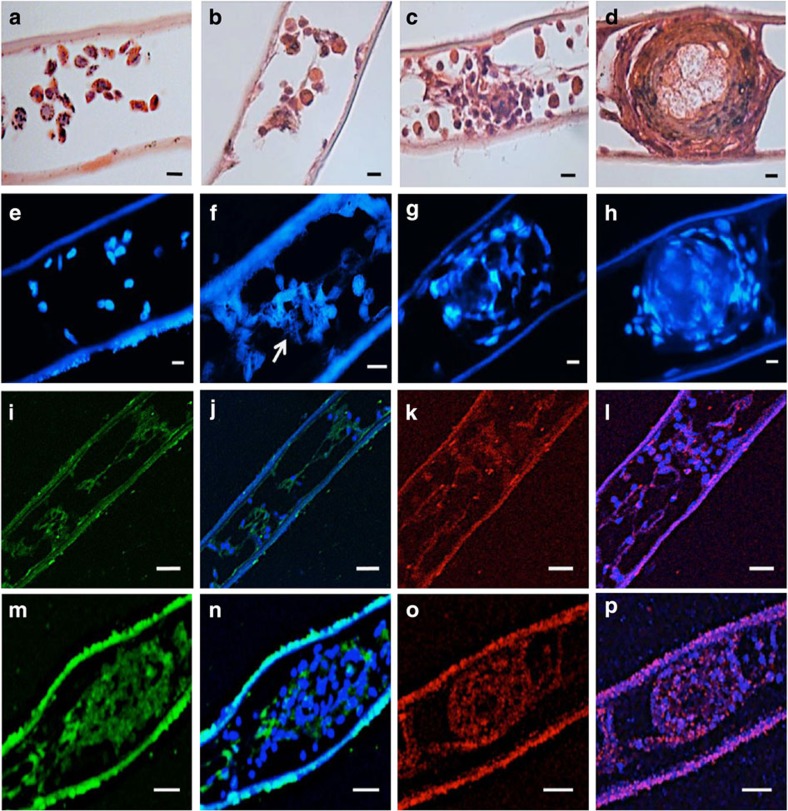
In vivo role of ETosis during host defence in C. maenas.(a–d) Haematoxylin and eosin-stained paraffin wax sections of gill lamellae at various incubation periods after 100 μl injection of LPS (20 μg ml−1) or saline. (a) Control, 24 h after injection of sterile saline. (b) Part of a gill lamella 1 h after LPS treatment. (c) Early capsule formed 3 h after LPS treatment. (d) Fully formed capsule 24 h after LPS injection. (e–h) 2-(4-amidinophenyl)-1H-indole-6-carboxamidine (DAPI)-stained paraffin wax sections of gill lamellae after 100 μl injection of LPS (20 μg ml−1) or saline. (e) Control, saline treatment (24 h). Epibionts are evident on the external (seawater) surface of the lower lamella surface and there is no haemocyte clumping or externalized chromatin. (f) 1 h post LPS treatment showing ETotic cells within a gill lamella. Arrow indicates likely externalized chromatin. (g) Haemocyte clump 3 h post LPS treatment. (h) Fully formed capsule 24 h post LPS treatment. (i–l) Immunohistochemical staining of haemocyte aggregations formed at 1 h post LPS treatment. (i) PXN visualization with anti-MPO antibody. (j) Merge of i with same section stained with TO-PRO-3 iodide to reveal DNA. (k) Visualization of H2A in a different area of lamella. (l) Merge of k with same section stained with TO-PRO-3 iodide. (m–p) Immunohistochemical staining of a haemocyte clump 3 h post LPS treatment. (m) Visualization of PXN with anti-MPO antibody. (n) Merge of m with same section stained with TO-PRO-3 iodide. Note the mostly extracellular location of PXN. (o) Visualization of H2A in a different clump. (p) Merge of o with same section stained with TO-PRO-3 iodide. H2A co-localization is pronounced and occurs throughout clump structure. All scale bars, 20 μm.